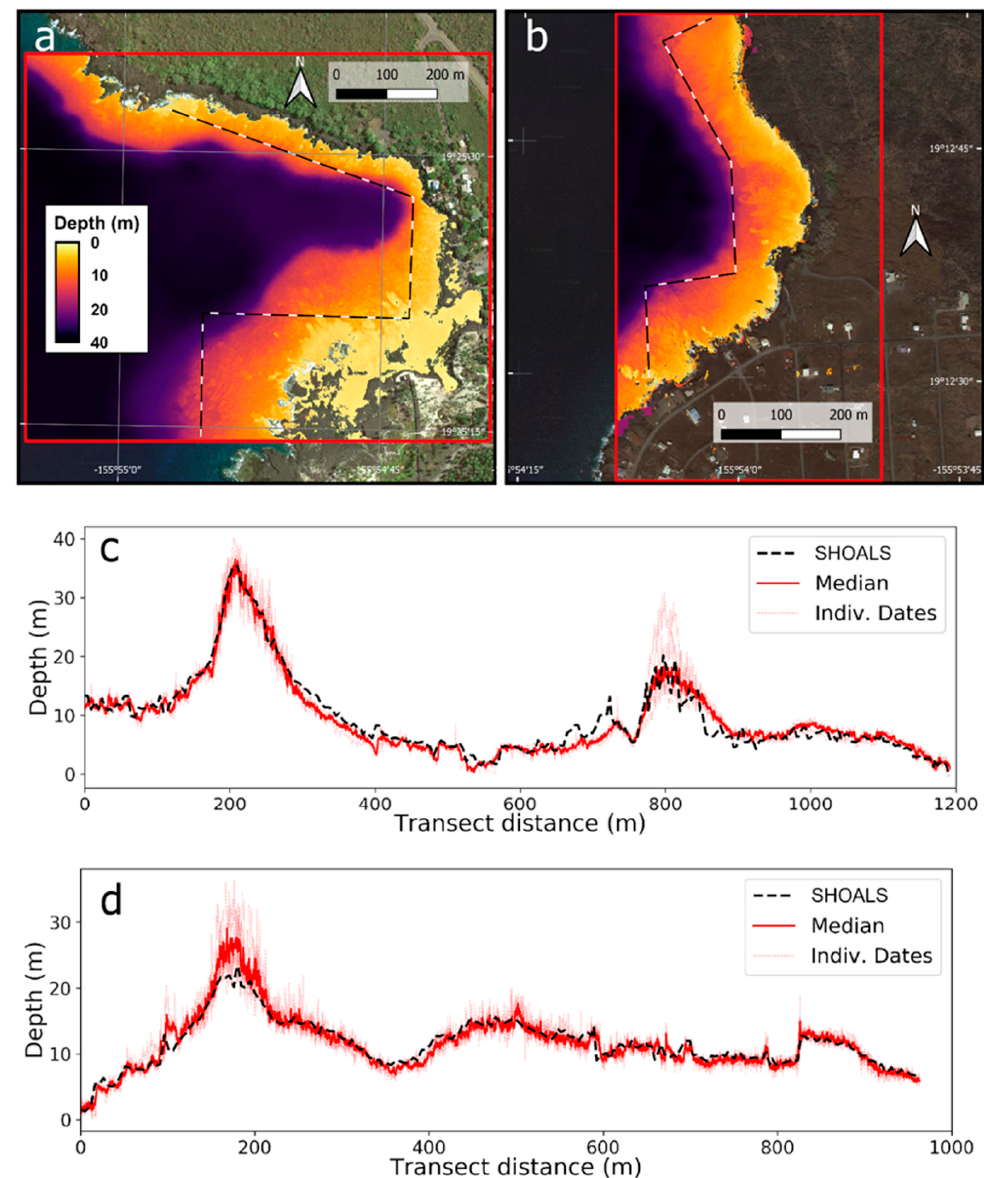
Figure 4. Demonstration transects from ( a ) Honaunau Bay and ( b ) P¯ap¯a Bay shown in black and white dashed lines. Green outlines show the extent of the SHOALS coverage. For the transect lines, the GAO VSWIR spectrometer-derived depth for individual dates are thin dashed red lines and the median is a thick solid red line. The SHOALS-derived depth is shown as a dashed black line for ( c ) Honaunau Bay and ( d ) P¯ap¯a Bay. Both transects start in the south end of the given site. Background satellite imagery © Google 2018.